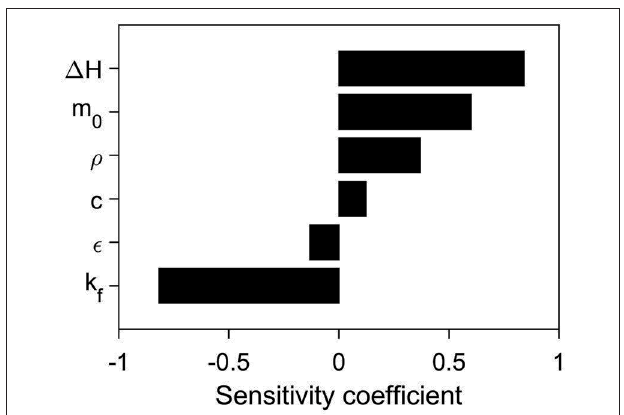
FIGURE 5 | The sensitivity coefficient of the different input parameters of the thermal model. The coefficients were calculated from the maximum thermal lag at 15 K/min of the variation of the base case and have been averaged from four simulations ( 25 and 50%). The base case conditions and parameters ± ± are given in Table 1